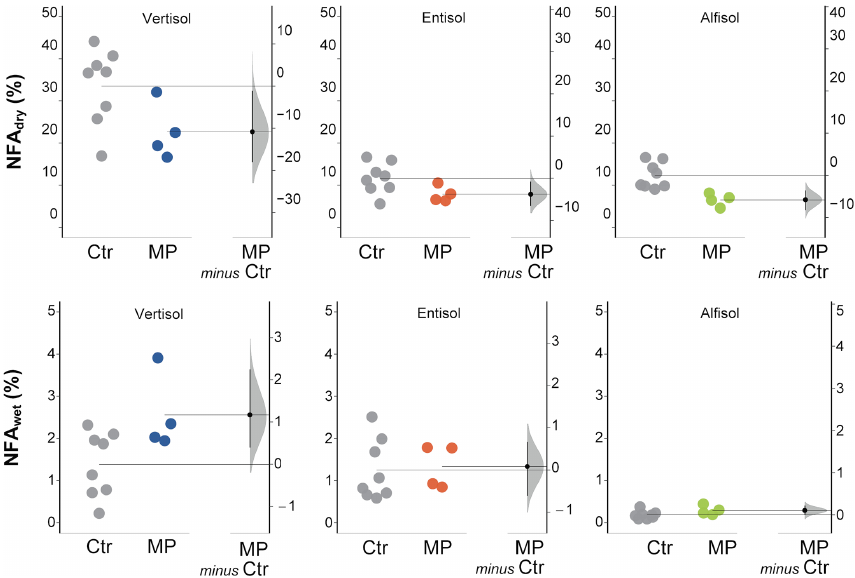
Figure 5. Newly formed aggregates ( > 600µm) calculated from dry (NFA dry ) and wet (NFA wet ) sieving. Raw data of control (Ctr, gray dots) and polyester MP fibers added to the treatment (MP, colored dots) are shown in the plot for each soil. The filled curve indicates the resampled distribution of the mean differences ( (cid:49) ), given the observed data. Horizontally aligned with the mean of the test group, (cid:49) is indicated by the black circle. The 95% confidence interval of (cid:49) is illustrated by the black vertical line.